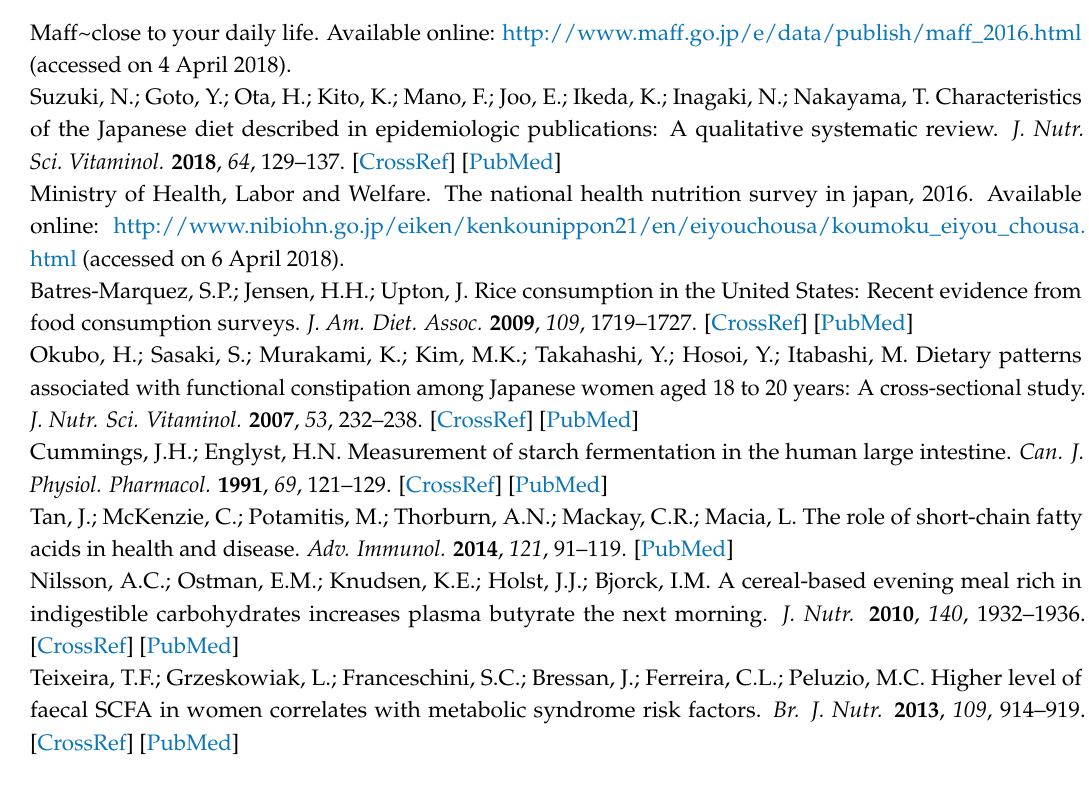
Table S1: Menu and food ingredients of the side dish sets on the 7th day of both test periods (bread and